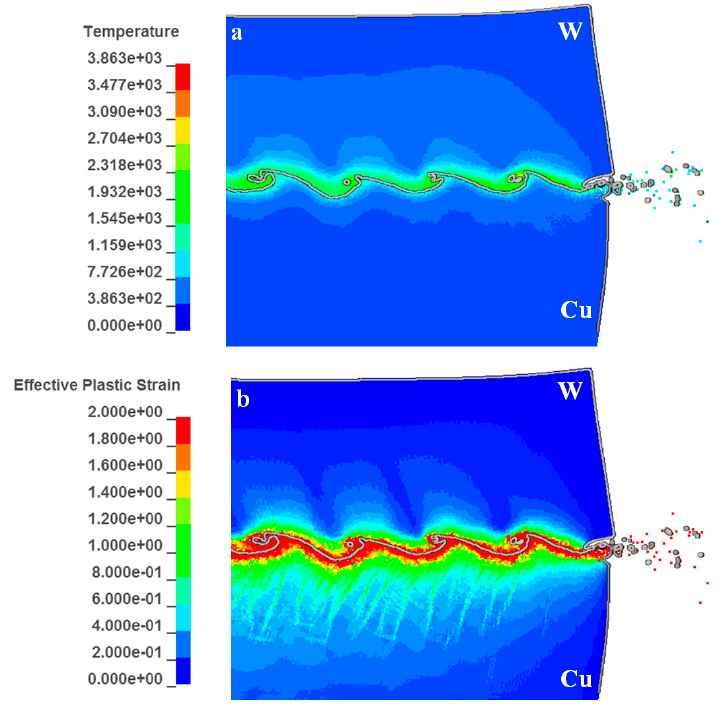
Figure 13. ( a ) Distributions of high temperature; ( b ) distribution of plastic strain at the interface.